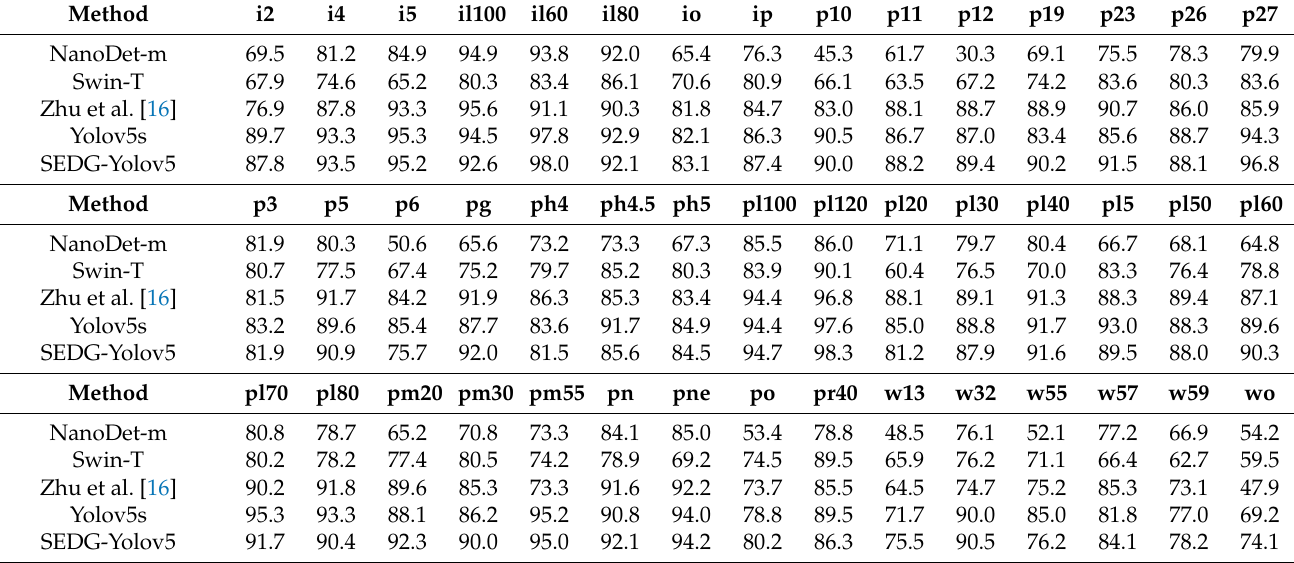
Table 3. Comparison of F1-score for the 45 selected categories in the TT100K dataset (in